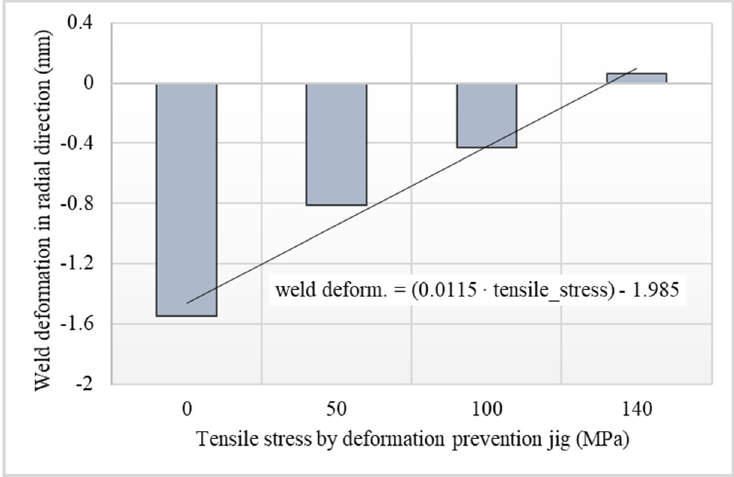
Figure 15. Final deformation of the center of welding line according to tensile stress.